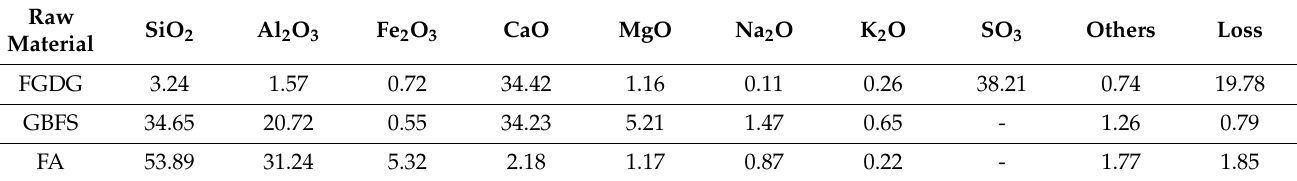
Table 1. Chemical composition of Portland cement